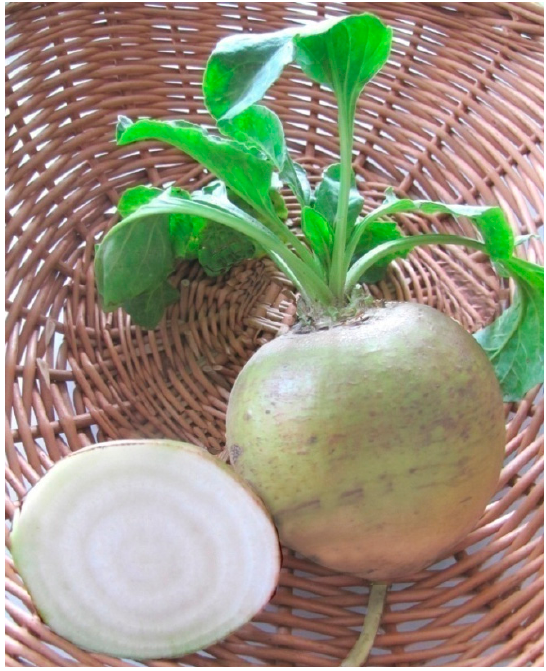
Figure 1. Beetroot “ Ś nie ż na Kula”. Ownership: Torseed S.A.